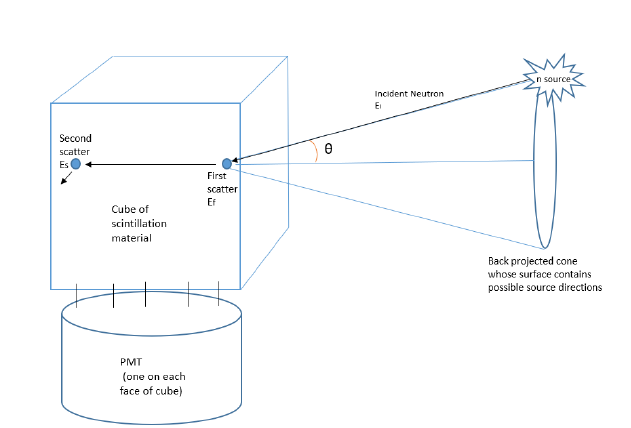
Fig. 1 . Basic operating principle of a monolithic neutron scatter camera. Neutrons emitted by nearby sources must scatter at least twice in the scintillator volume. The scattering positions are determined by comparing the amount of light arriving at each of the six PMTs mounted to the six surfaces of the scintillator. By solving a series of kinematic equations, a probability cone whose surface contains the possible trajectories of the neutron can be back- projected into 3-D space. Many correctly back-projected cones will converge to the source location.